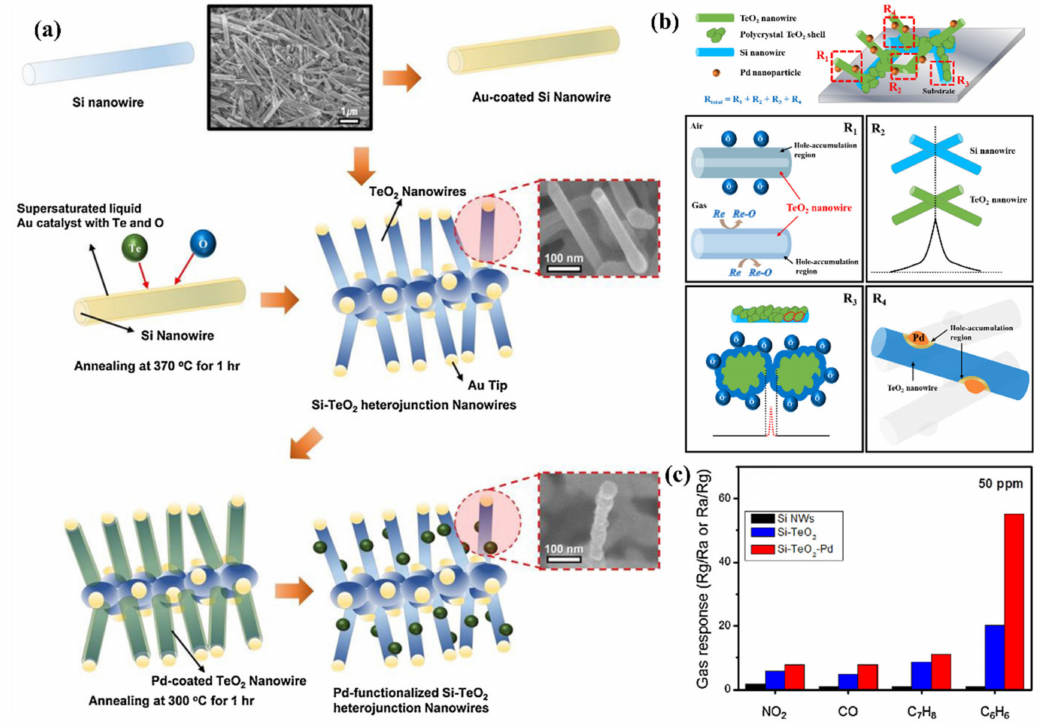
Figure 32. ( a ) Fabrication processes of the Pt-functionalized TeO 2 -branched Si nanowires, ( b ) schematic diagram showing the four mechanisms being operated in the Pd-functionalized branched nanowires: (R 1 ) modulation in the hole accumulation along the branch TeO 2 nanowires, (R 2 ) modulation of the potential barrier at the networked homojunctions between the branch TeO 2 nanowires, (R 3 ) modulation of the potential barrier at the boundaries of the nanograins and (R 4 ) modulation of the potential barrier at the Pd-TeO 2 heterojunctions (including additional Pd e ff ects), and ( c ) column bar graph showing the variation of sensor responses by addition of TeO 2 branches, Pd-functionalization, and varying the gas species at 50 ppm. The sensing temperature was 200 ◦ C. Reproduced from [175], with permission from Elsevier,